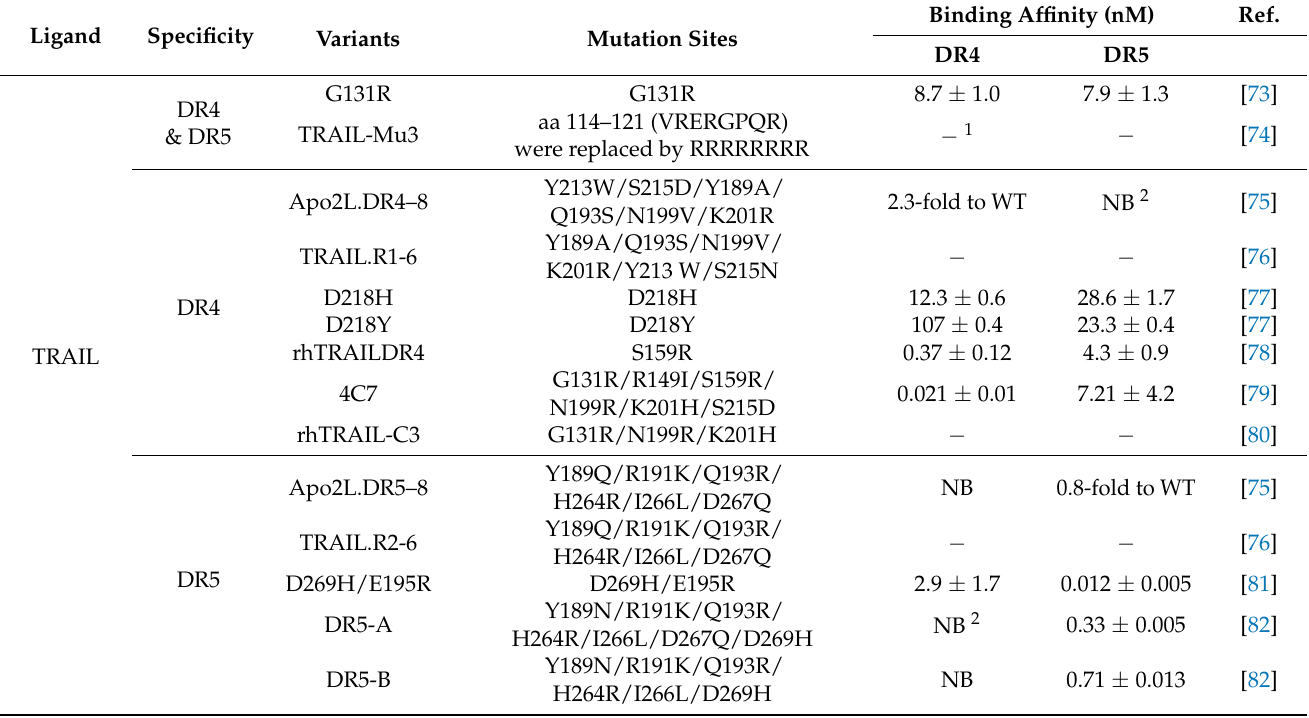
Table 2. The mutation sites and binding affinity of the receptor-specific TRAIL